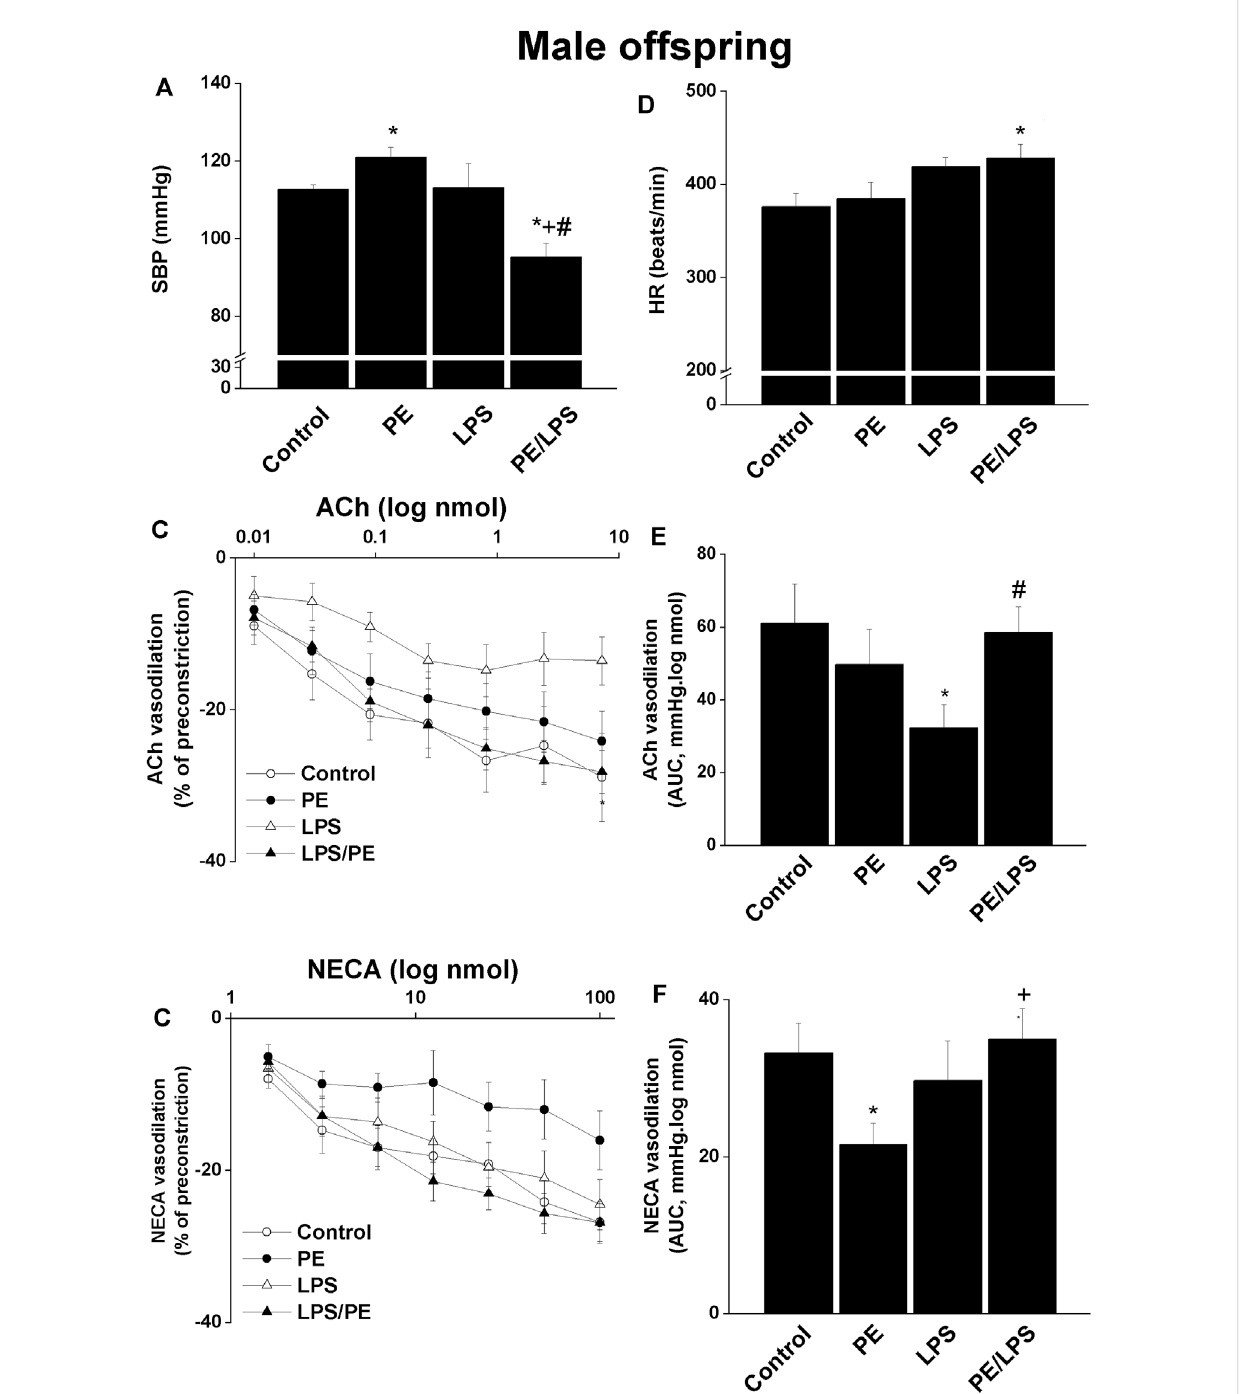
FIGURE 1 Effect of PE on tail cuff systolic blood pressure (SBP, panel A ), heart rate (HR, panel D ), cumulative vasodilatory dose response curves of ACh and NECA(panels B,C )andAUCsofthevasodilatorydoseresponsecurves(panel E,F )inphenylephrinepreconstrictedisolatedperfusedkidneysofendotoxic male offspring, respectively 4 h post intraperitoneal injection of LPS (5 mg/kg) or equal volume of saline. Data are expressed as the mean ± SEM of 7- 8 measurements. ANOVA followed by the Tukey ’ s post hoc was utilized to measure statistical signi fi cance. * p < 0.05 vs. “ Control ” , + p < 0.05 vs. “ PE ” and # p < 0.05 vs. “ LPS ”